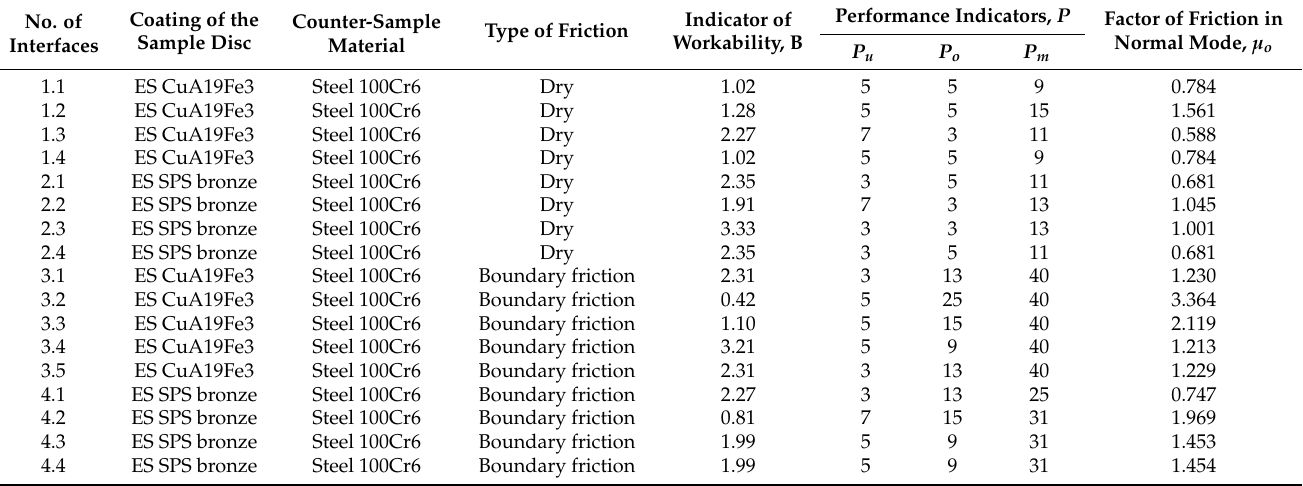
Table 6. Assessment of the electrospark coating interface properties of tank-drive units of CuAl9Fe3 and SPS bronze.